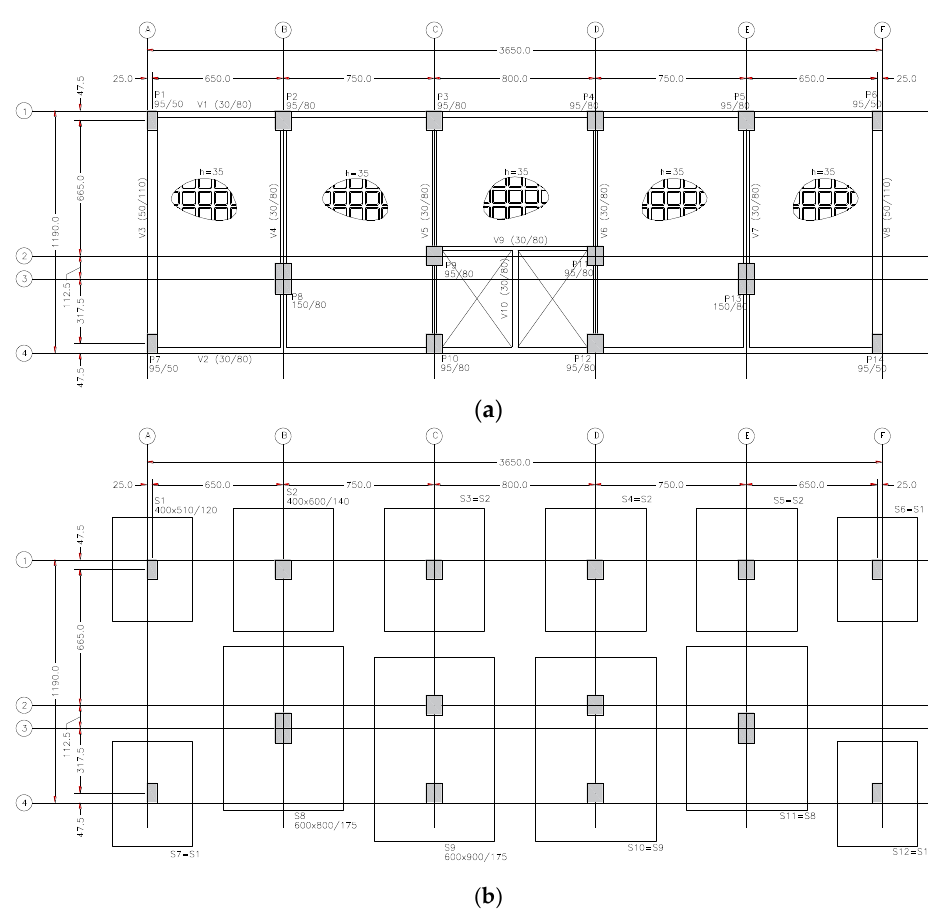
Figure 3. Building structural design (cm): ( a ) standard storey; ( b ) foundations.